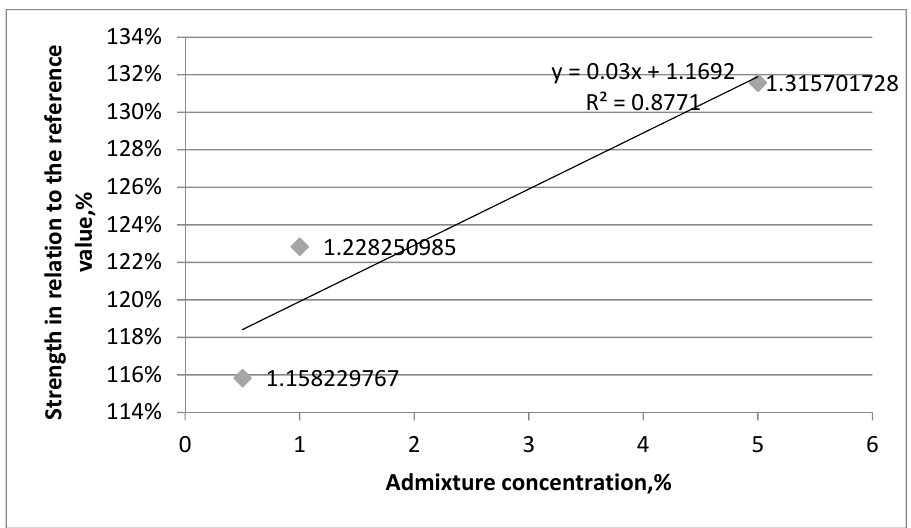
Figure 8. Compressive strength change depending on the type and amount of nanosilica additive— correlation analysis for cement slurry with nanosilica type 2.